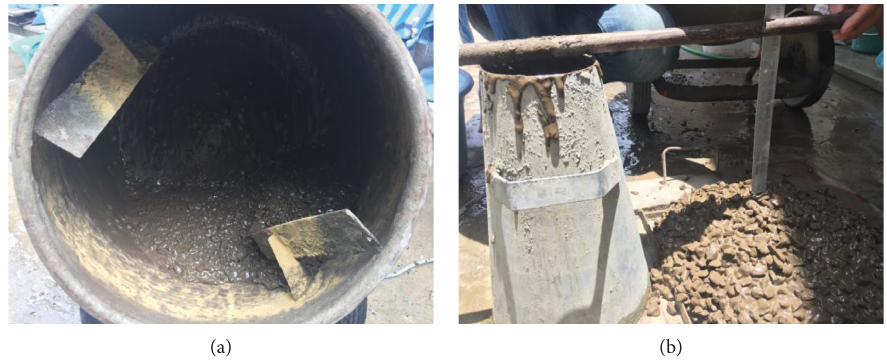
Figure 2: Fresh AAHFAC (a) and slump test of the AAHFAC